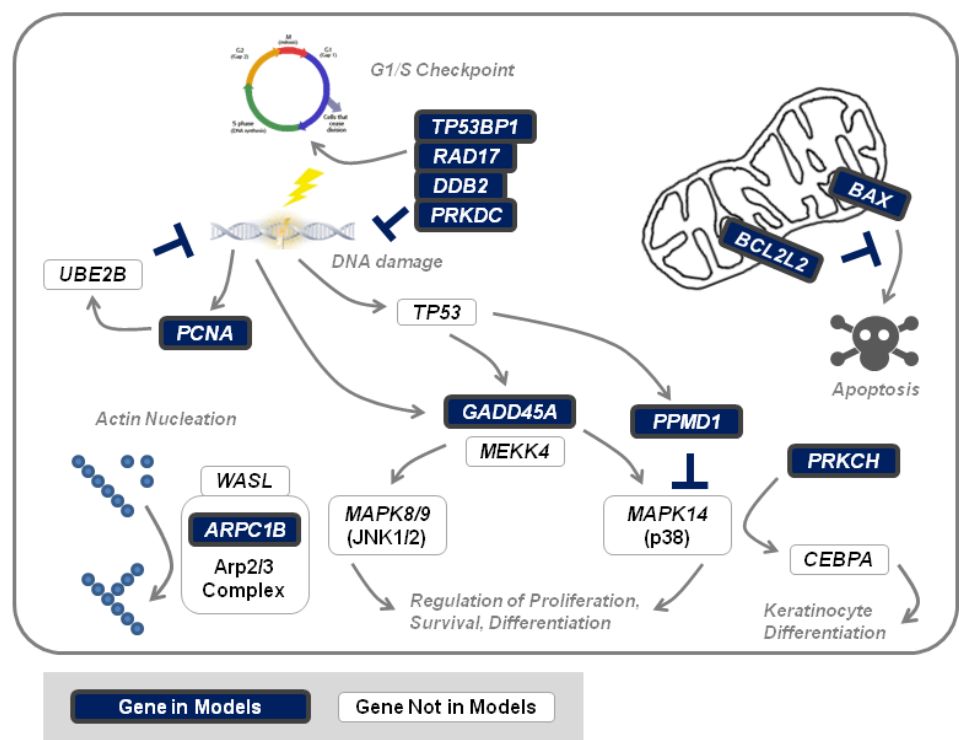
Figure 8. Depiction of major cellular functions of most frequently appearing genes of the best human signatures (see Figure 5 and Figure 6).